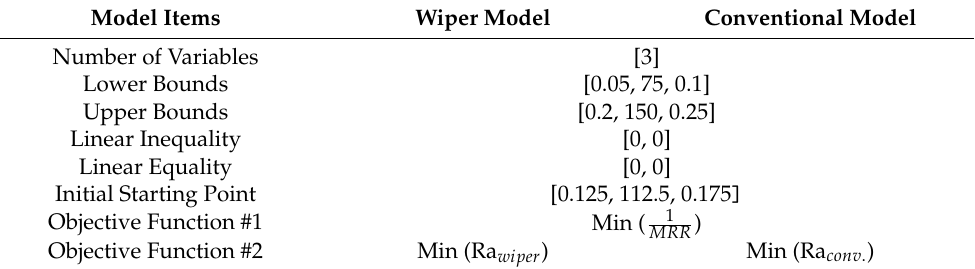
Table 5. The developed optimization mathematical models of the